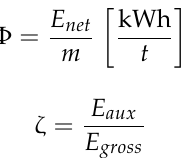
Table 4. Substrates chosen from the authors along with their biogas production per unit of mass.